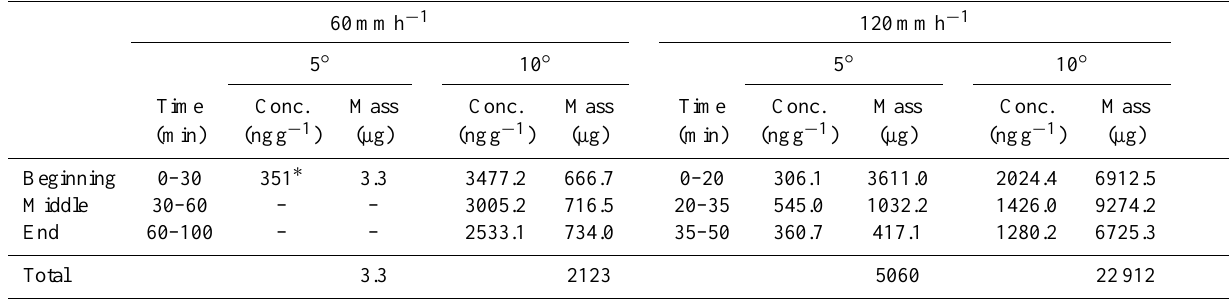
Table 3. Concentrations of 5 β -stanols in the eroded sediment (dry weight basis) through time and the total exported mass throughout the